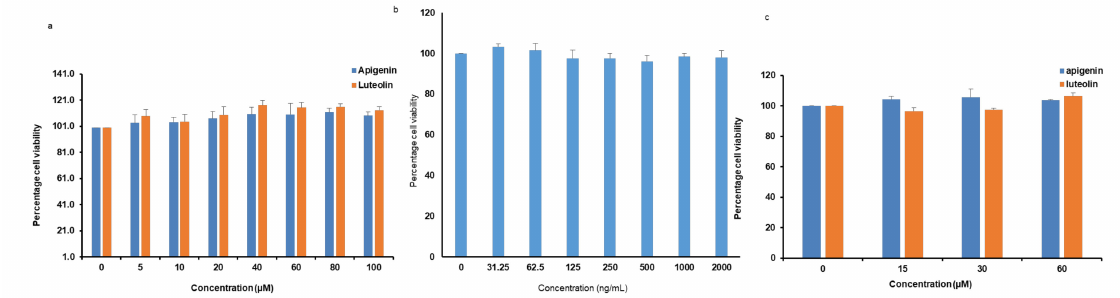
Figure 1. Apigenin, luteolin, and lipopolysaccharides (LPS) showed no cytotoxicity to the microglial cell. Microglial cells (5 × 10 5 cells / mL) were cultured and treated with apigenin or luteolin at indicated concentrations ( a ); LPS at indicated concentrations ( b ); and apigenin or luteolin at 0, 15, 30, and 60 µ M and treated with 2000 ng / mL ( c ) for 24 h before cell viability studies were performed. The results are presented as the mean ± standard deviation (SD) ( n =